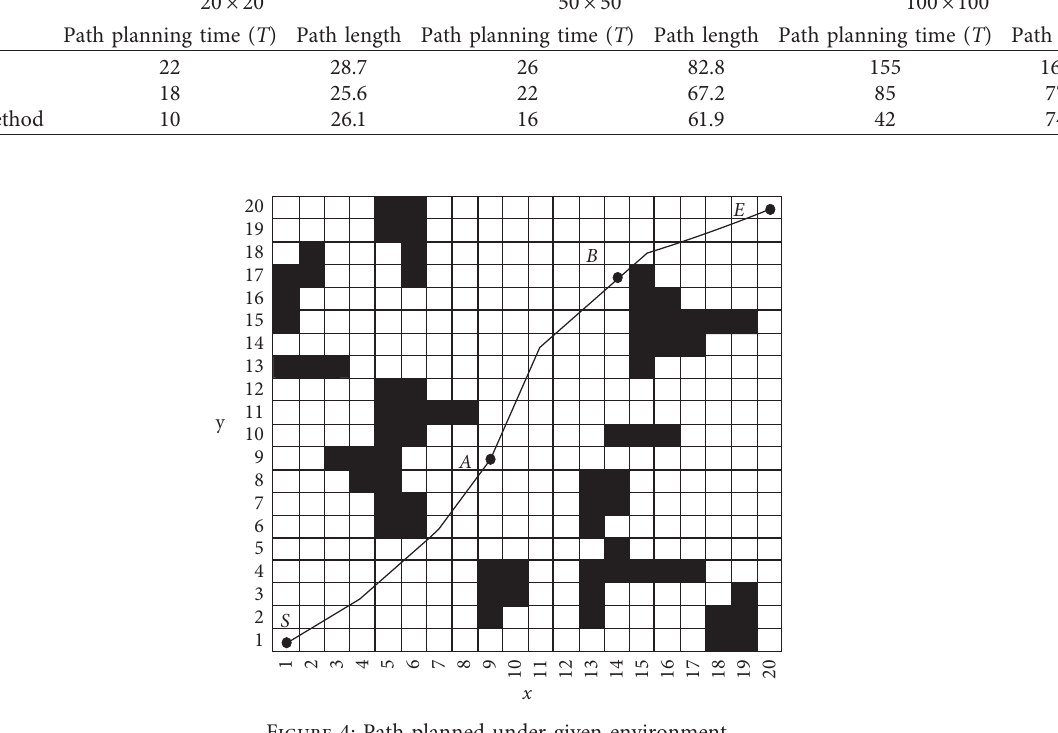
Figure 4: Path planned under given environment.